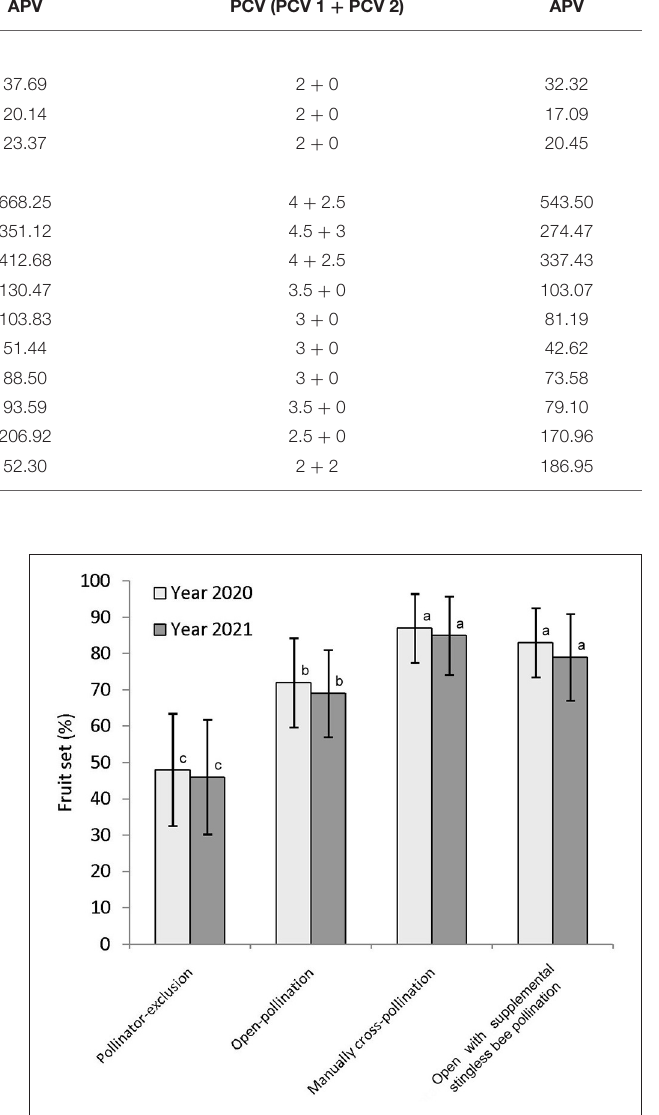
TABLE 5 | Pollen carrying value (PCV) and approximate pollination value (APV) of dominant floral visitors. Floral visitors In open condition (i.e., without field manipulation)